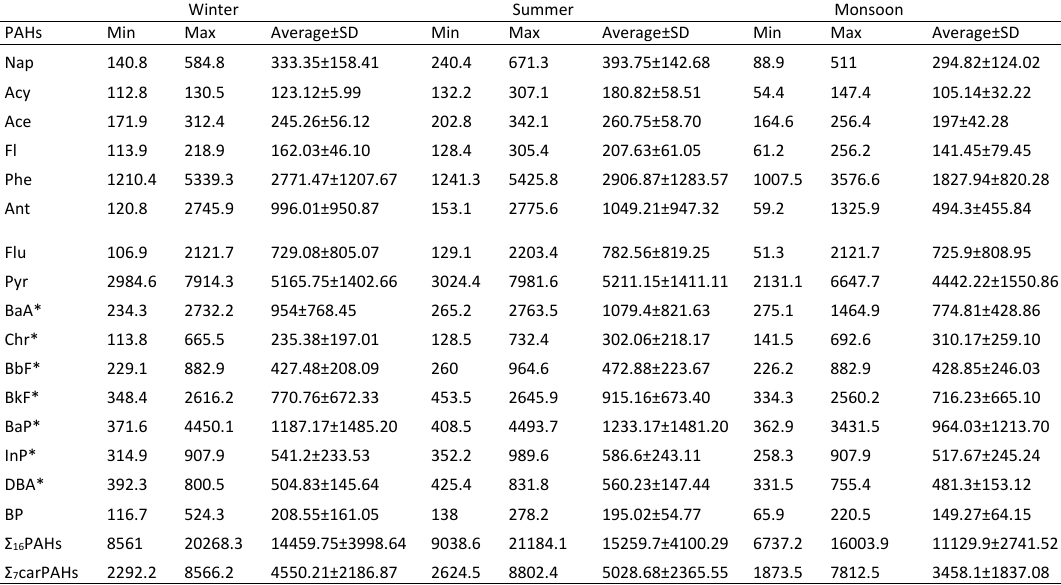
Table 1: PAHs concentration (µg/kg) in soil n=10 each for three different seasons Winter